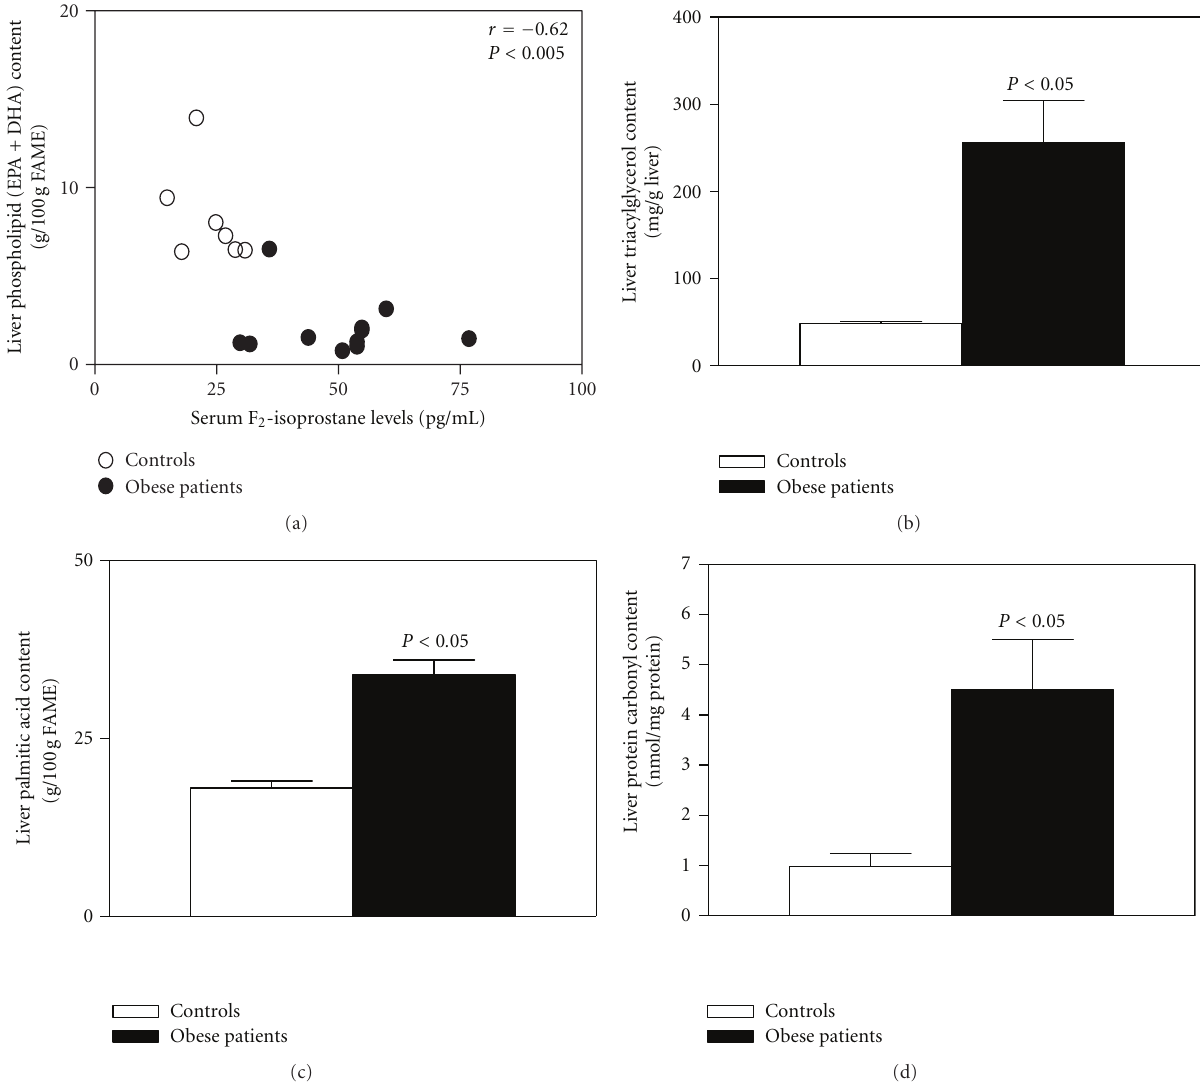
Figure 2: Correlation between liver phospholipid content of LCPUFA n-3 and F 2 -isoprostane levels in serum as index of oxidative stress (a) and contents of liver triacylglycerols (b), palmitic acid (c), and protein carbonyls (d) in control subjects and obese patients with steatosis. LCPUFA n-3 content corresponds to eicosapentaenoic acid (EPA) plus docosahexaenoic acid (DHA), expressed as g/100 g fatty acid methyl esters (FAME). Correlation in (a) was carried out by Spearman rank order correlation coe ffi cient (unpublished data). Data (means ±